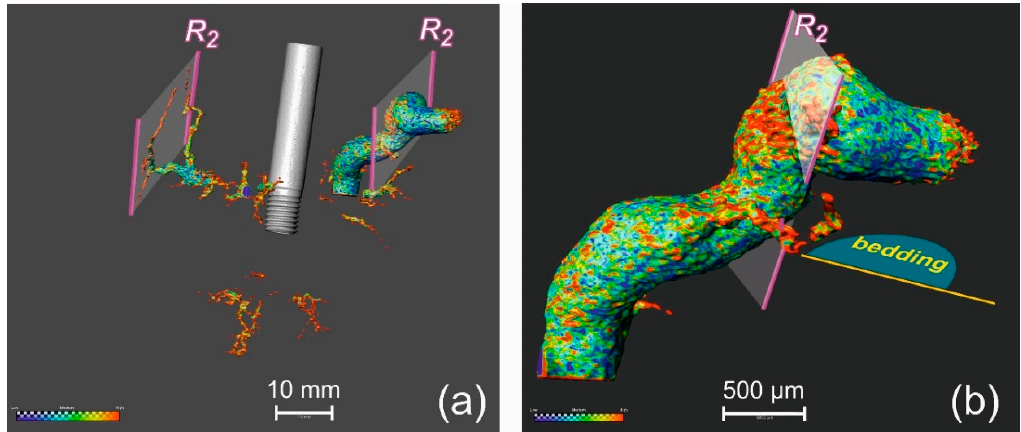
Figure 15. 3D model of the mean curvature distribution, H, for ( a ) the entire dissolution pattern and ( b ) the principal wormhole. Maximally and minimally curved areas are shown in red and in blue, respectively.